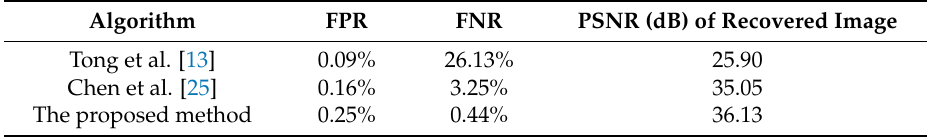
Figure 7. Tamper detection and recovery performance for copy-move attack: ( a ) Original Goldhill image; ( b ) watermarked Goldhill image; ( c ) attacked image; ( d ) tamper detection result using the method in [13]; ( e ) tamper detection result using the method in [25]; ( f ) tamper detection result of the proposed method; ( g ) image recovery result using the method in [13]; ( h ) image recovery result using the method in [25]; ( i ) image recovery result of the proposed method. Table 4. Performance comparisons for copy-move attack using Goldhill